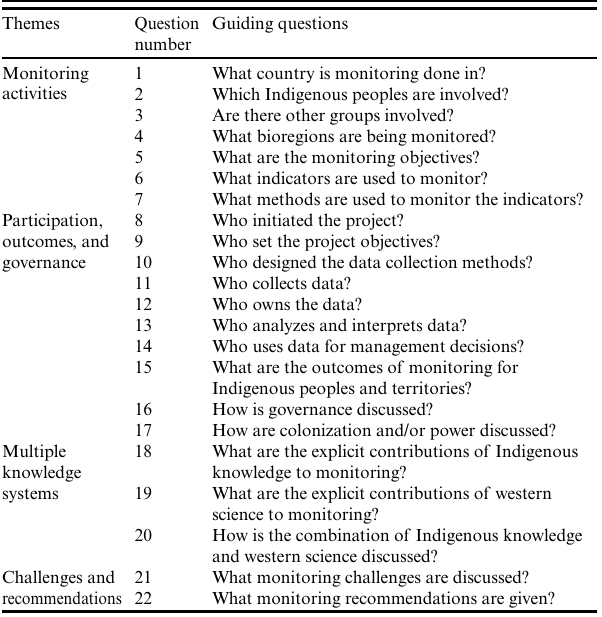
Table 1 . Themes and guiding questions for literature review and analysis.